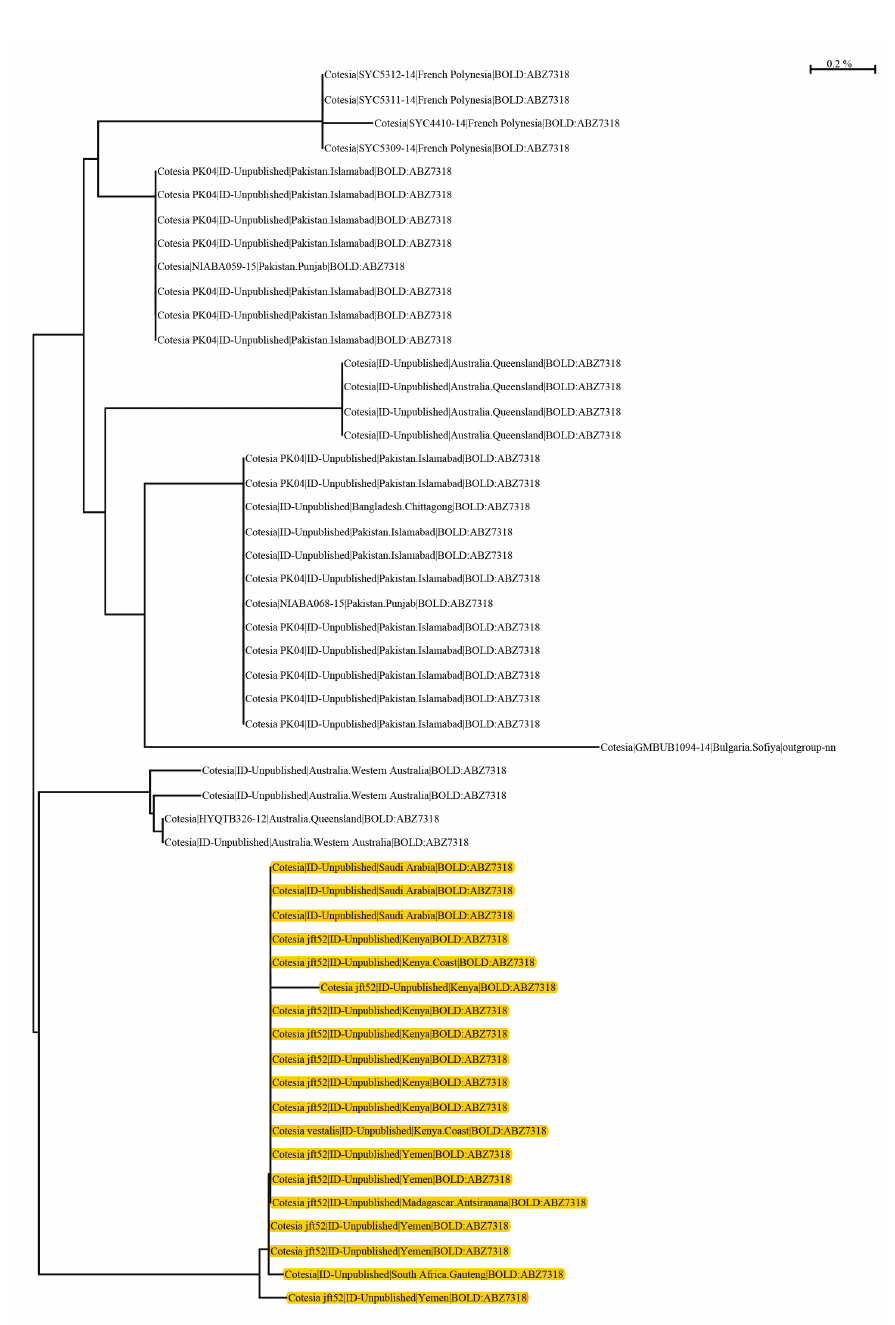
Figure 4. Neighbor-joining tree (K2P) of all specimens in the Barcoding of Life Data System (BOLD) currently associated with BIN BOLD:ABZ7318 (for explanation on the BIN concept see Methods of this paper). The cluster highlighted in Yellow in the tree shows the specimens considered in the present paper as Cotesia icipe